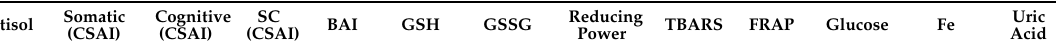
Table 4. Correlation matrix between anxiety scores, cortisol and biomarkers of oxidative stress in plasma of novice jiu-jitsu athletes before their first official competitions. (N = 13).